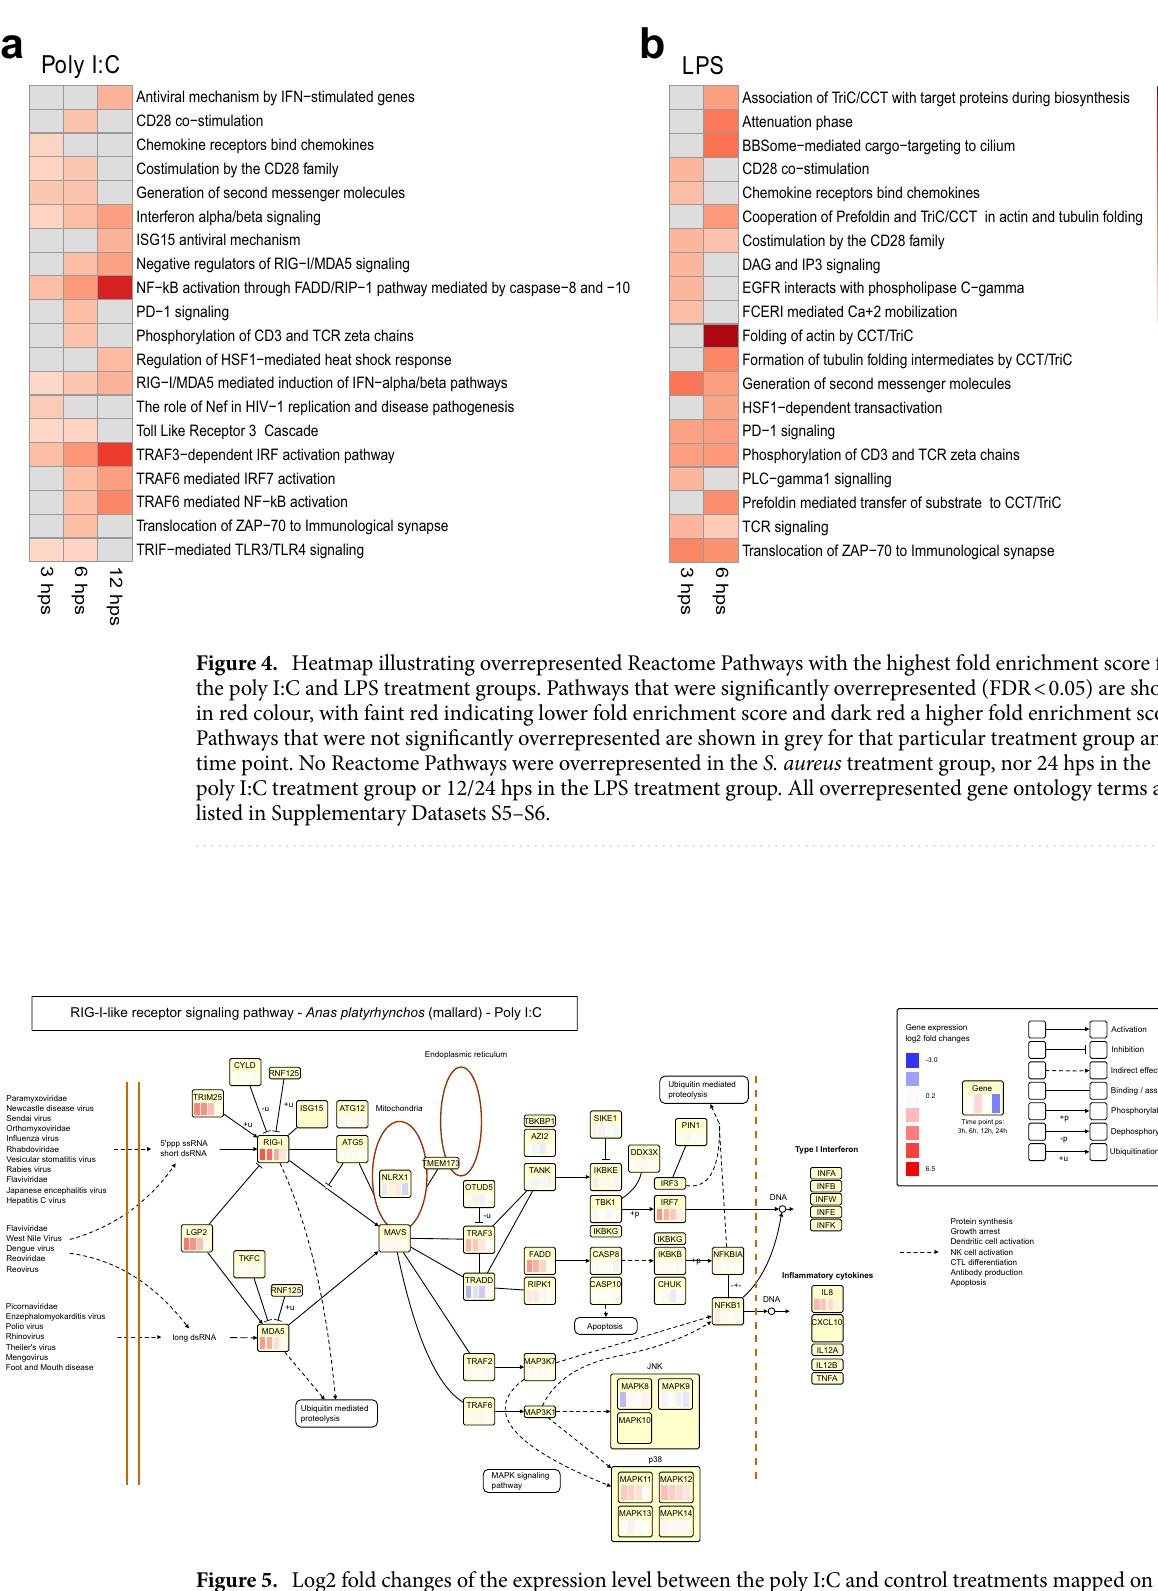
Figure 5. Log2 fold changes of the expression level between the poly I:C and control treatments mapped on the RIG-I like receptor signaling pathway from the KEGG database 34–36 . Red indicates that the gene expression was higher, and blue indicates that the gene expression was lower in the poly I:C treatment group than in the control group. White indicates no change or a similar change in the poly I:C treatment group as in the control group. Each box represents one gene in the pathway and the columns within the box show the gene expression fold change for the four time points; 3, 6, 12 and 24 hps from left to right. For more details see http:// orn- files. iwww. mpg. de/ dgeviz/ RIG_ PICBu tton.